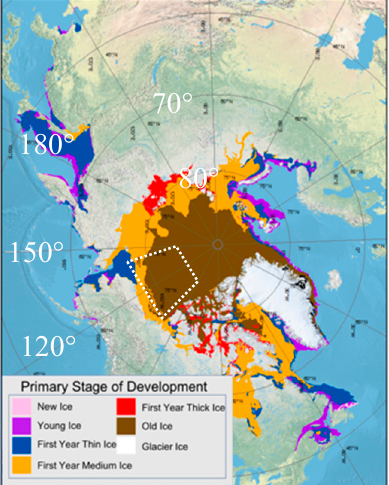
Figure 14. Arctic sea ice primary stage of development obtained from the NOAA National Ice Center website (https://www.natice.noaa.gov) for February 2018. The brown color corresponds to old ice, and red, orange and blue color correspond to three types of first year ice. Pink color corresponds to new ice and purple color to young ice. The white dotted box defines the calibration target area selected for this study.